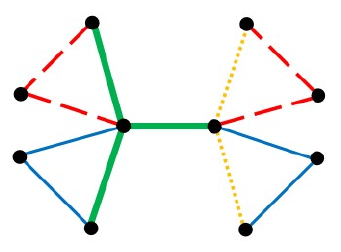
Figure 4. The bow-tie graph B and a 4-liec of